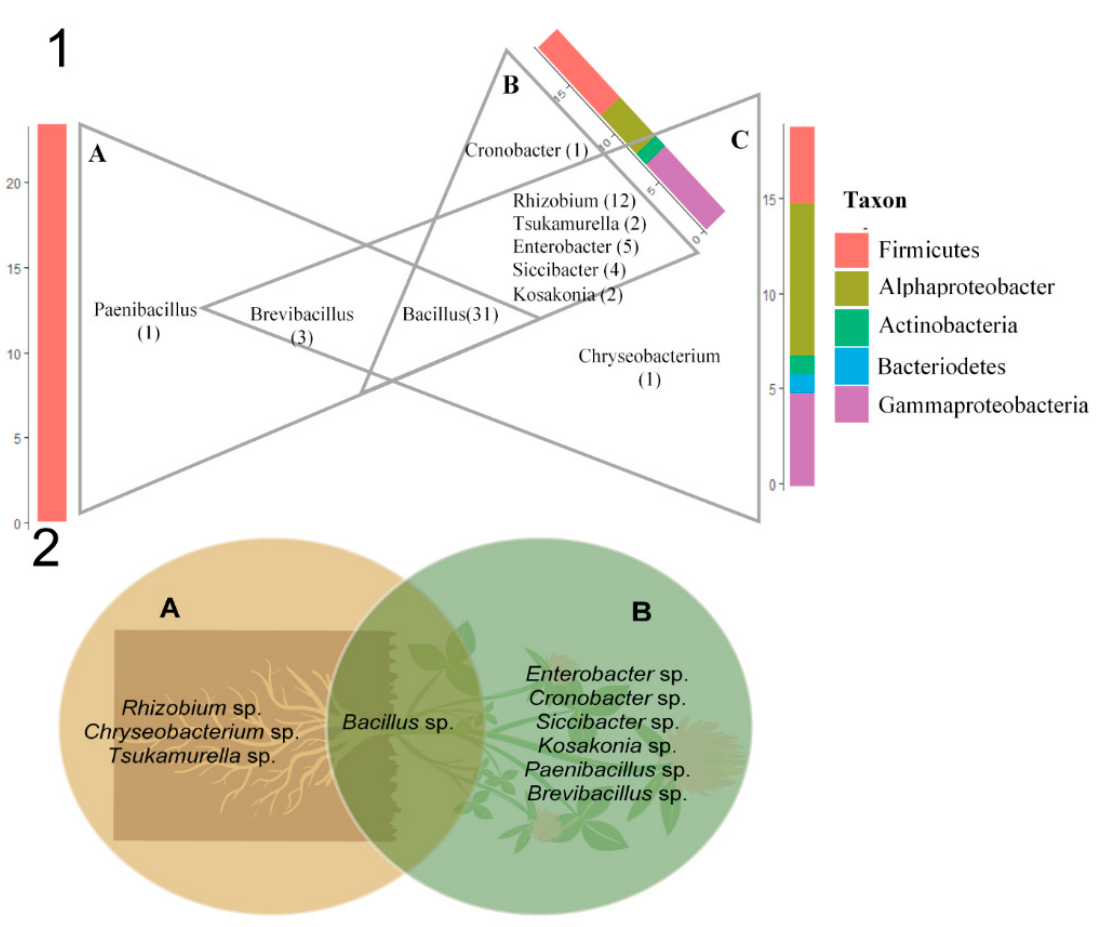
Figure 5. Based on 16S rRNA gene sequencing, the higher abundance of multiple genera of cultivable clover endophytes developed on plant broth ‐ based culture media compared to modified R2A : 1 . Culture media effect: Venn diagram representing the bacterial isolates recovered by all tested culture media and their taxonomic affiliation (taxon and genera levels): ( A ) modified R2A, ( B ) clover broth culture medium, and ( C ) wheat broth culture medium. 2 . Plant compartments effect: Venn diagram representing the abundance of bacterial genera recovered in plant compartments, irrespective of culture media: ( A ) endo ‐ rhizosphere, ( B ) endo ‐ phyllosphere.